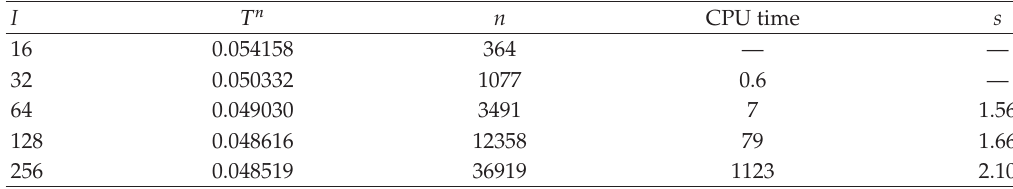
Table 8: Numerical blow-up times, numbers of iterations, CPU times (cid:3) seconds (cid:4) and orders of the approximations obtained with the implicit Euler method defined in (cid:3) 10.2 (cid:4)